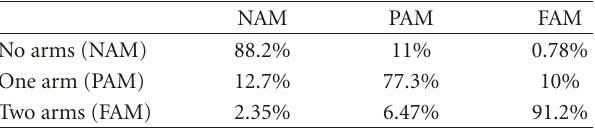
Table 5: Confusion matrix for classification rates of three human motions at 30 ◦ using a MLP as classifier in Stage 3 of